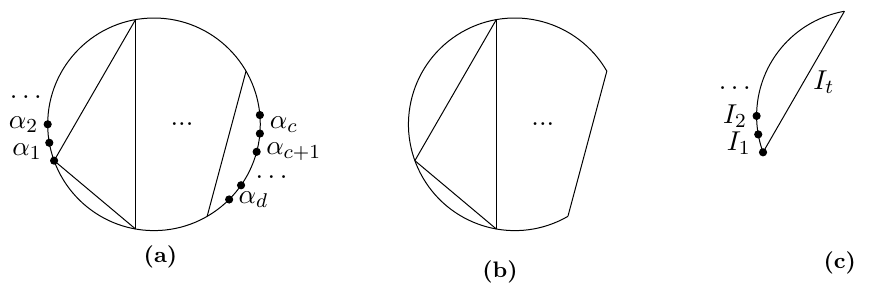
Figure 6. The reduction of the mutual partial triangulation for the general expansion of